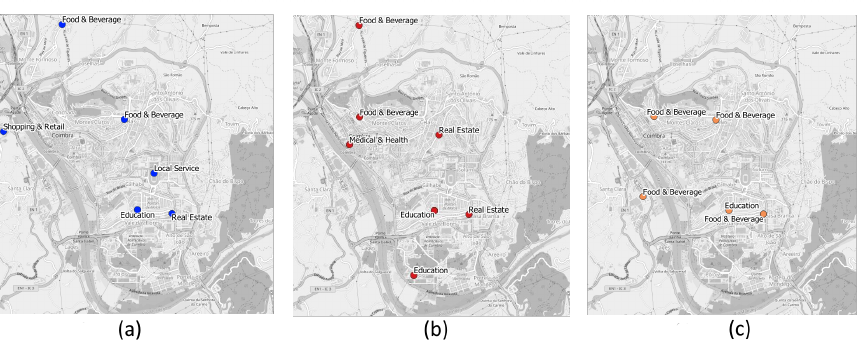
Figure 6. Routine locations classified for one user: ( a ) time interval from 9 a.m.to 12 a.m.; ( b ) time interval from 12 a.m.to 2 p.m.; and ( c ) time interval from 2 p.m. to 5